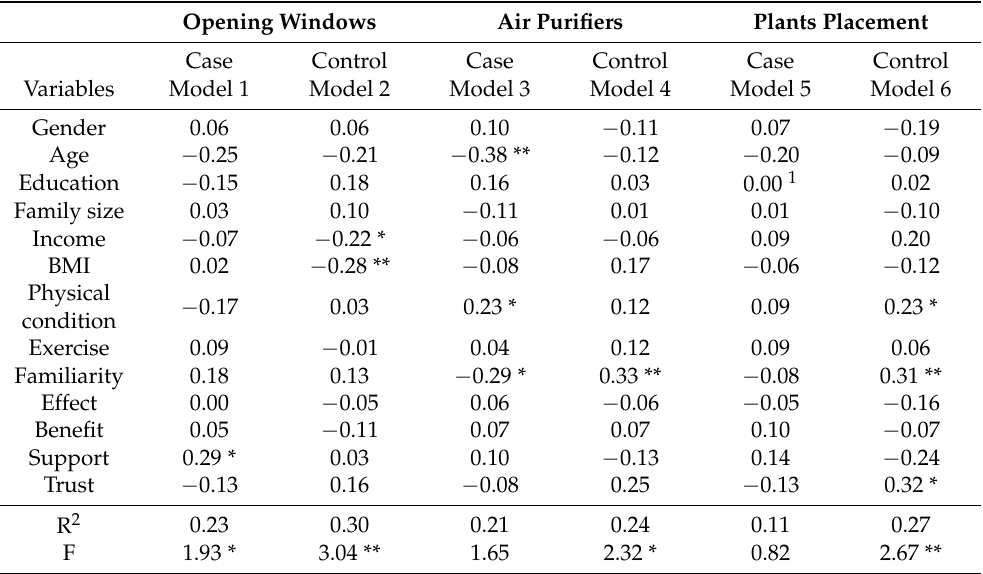
Table 5. Multiple linear regression models of protective behaviors by demographic variables and risk perception factors.